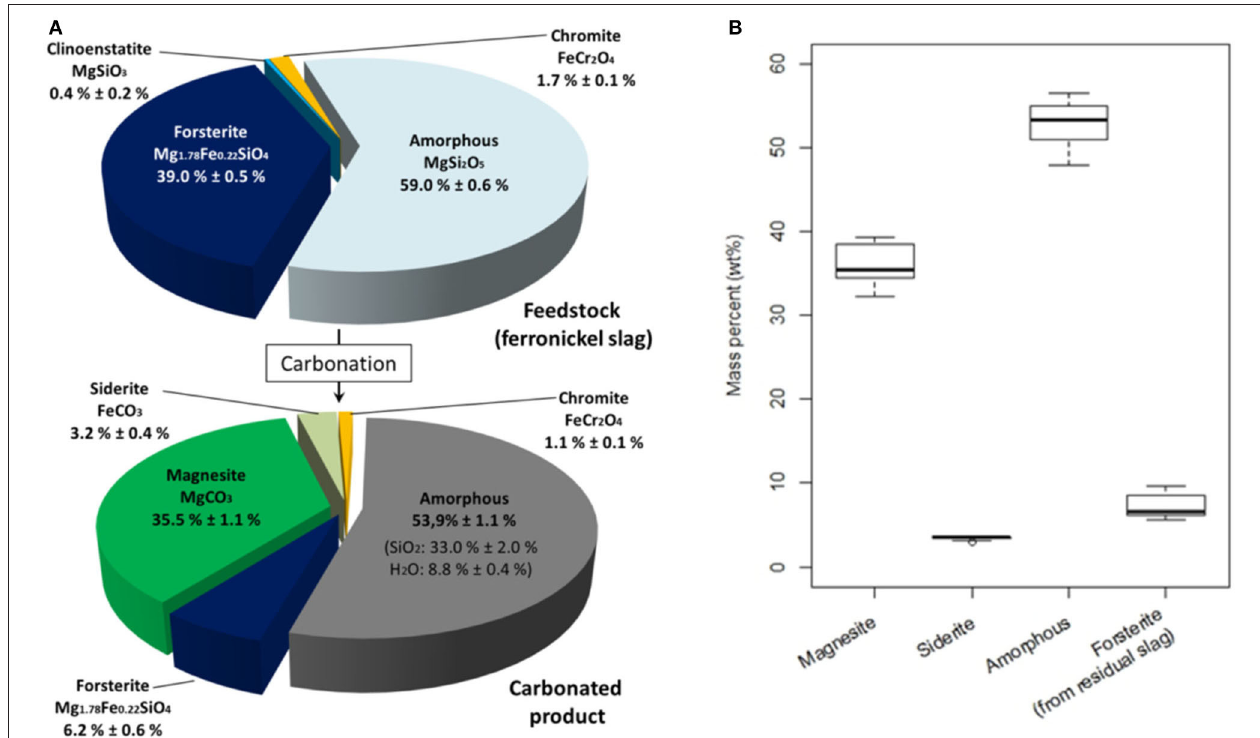
FIGURE 11 | Mineralogical composition of feedstock (ferronickel slag) and carbonated products (A) Mineralogical speciation (wt%). (B) Mineralogical composition (15 observations) of carbonation products after 24h of reaction.